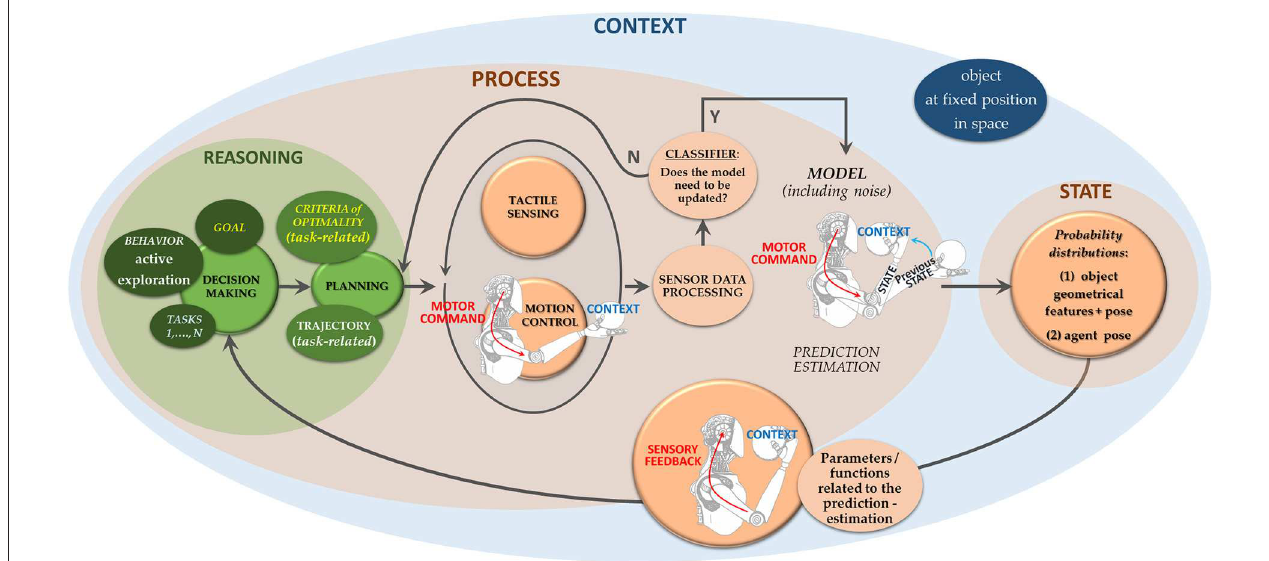
FIGURE 5 | Taxonomy for active exploration based on probabilistic approaches: the scheme reported in Figure 1 has been enriched with conceptual pictures adapted from human motor control theory ( Wolpert and Ghahramani, 2000) into robot-like schemes (with permission from the authors of the original pictures). In particular, at each step of the sensorimotor loop a model of the system state is done, which relies on noisy data. A representation is thus given of the system state which is based on probability distributions of features and poses. Related parameters and functions are fed back to the reasoning stage to plan and control the next motion step. Sensor data acquired during motion enables the system to tune the model according to the new sensory